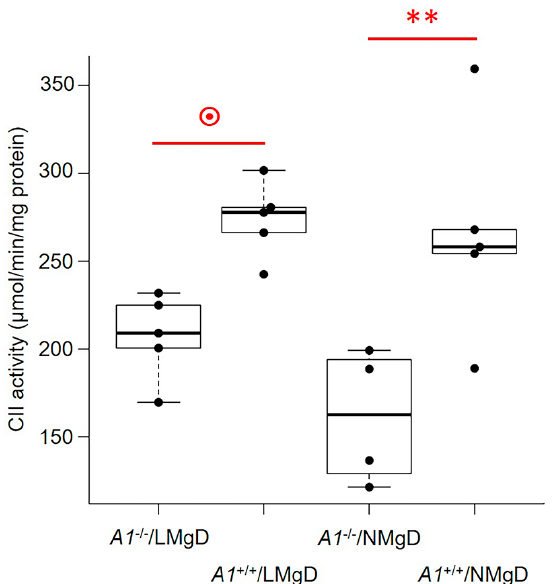
Figure A6. Post-hoc Tukey’s range test/CI. The CI activities presented as box-and-whisker plot overlaid with dot plot; dots represent raw input values for each analyzed group ( Slc41a1 − / − animals on LMgD, Slc41a1 +/+ animals on LMgD, Slc41a1 − / − animals on NMgD, and Slc41a1 +/+ animals on NMgD); * p < 0.05. Abbreviations: A1 , Slc41a1 ; CI, complex I; LMgD, low Mg diet; NMgD, normal Mg diet.